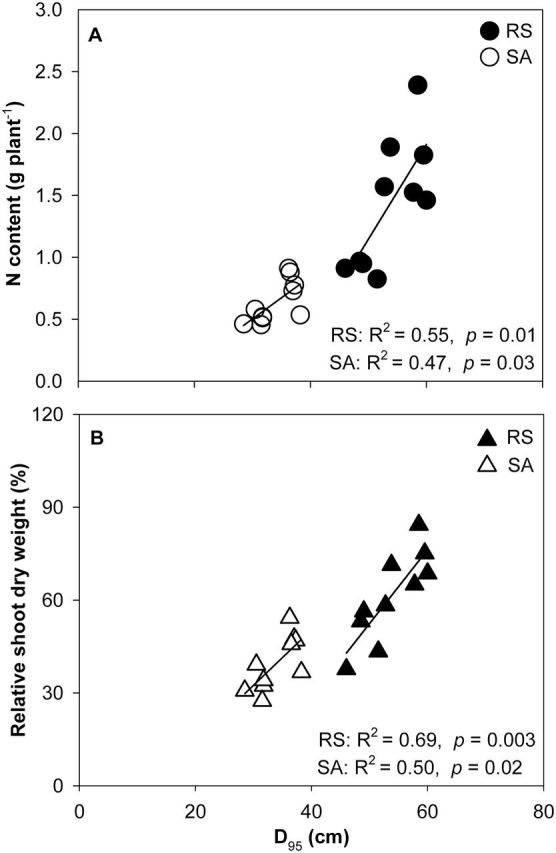
Correlation of N content (A) and relative shoot dry weight (% of shoot dry weight in high N) (B) with rooting depth (D95) in the field in RS and SA at anthesis. Each point is the means of four replicates of each genotype.